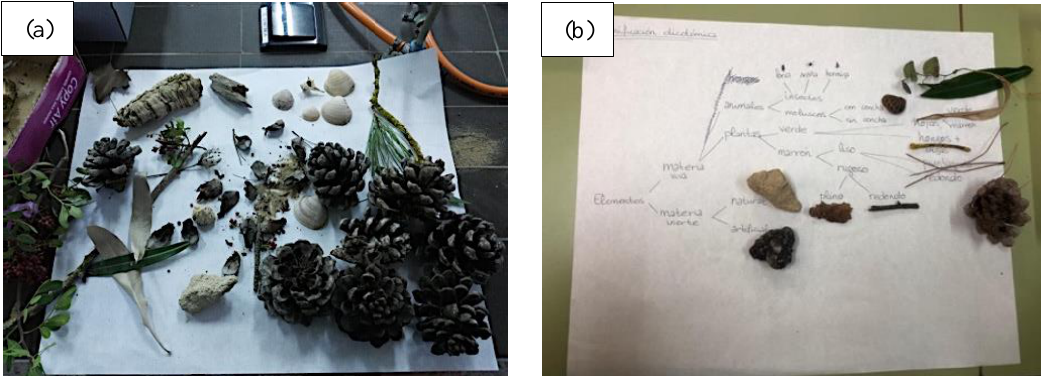
Figure 2. Practicum 3. What is alive? What are the components that make the natural environment? a) Samples collected during fieldwork in the natural park 'Los Toruños'; b) Design of a dichotomous key using collected samples from the natural environment